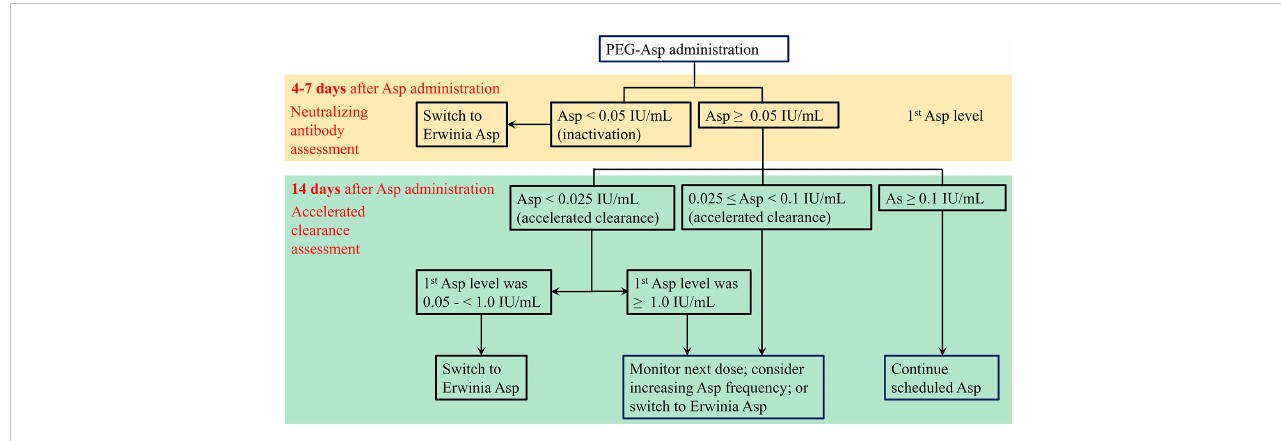
FIGURE 6 PEG-Asp activity monitoring algorithm for assessing possible silent inactivation by neutralizing antibodies and/or accelerated clearance